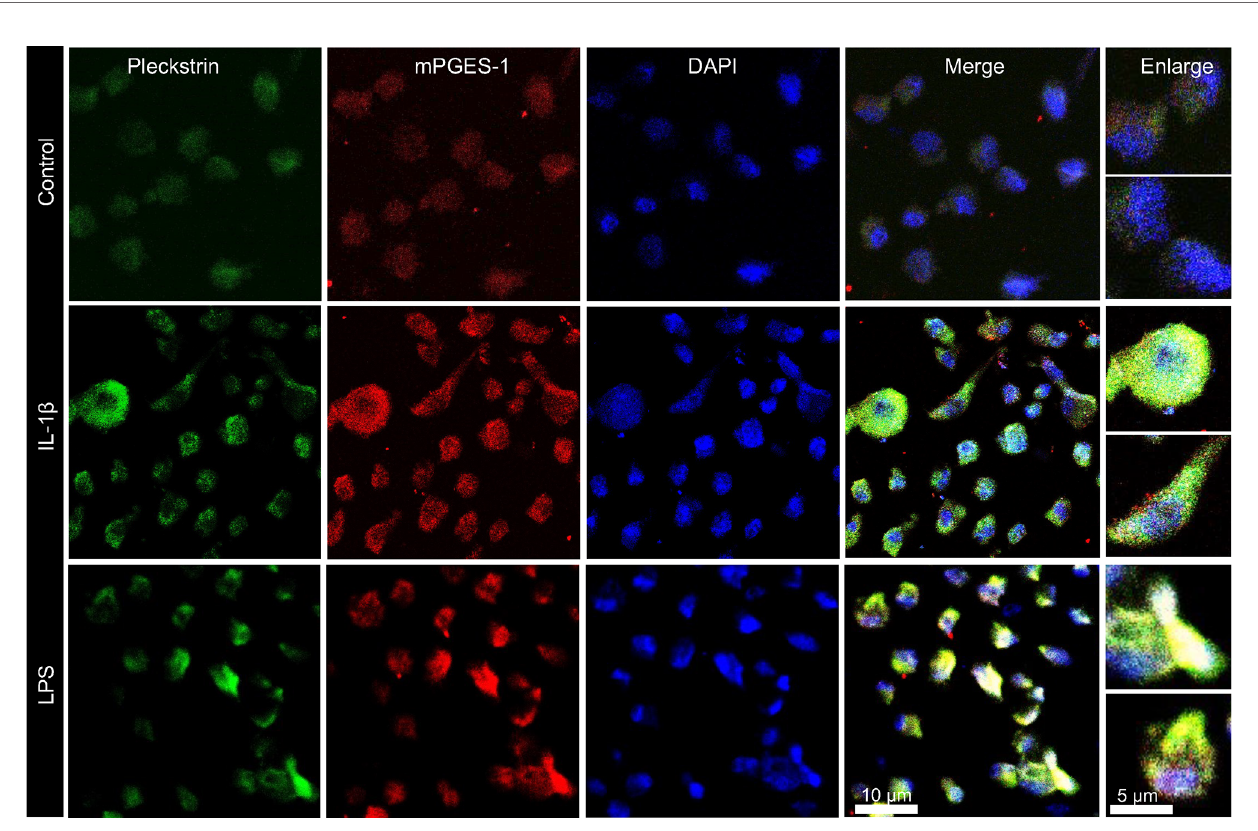
FIGURE 6 | Visualization and co-localization of pleckstrin protein with mPGES-1 in unstimulated control and IL-1 b or LPS stimulated HGFs using confocal microscopy. Immuno fl uorescence staining of fi broblast cells showing co-localization of pleckstrin (green) with mPGES-1 (red), an in fl ammatory marker, and DAPI (blue), a nuclear marker. Scale bars: 10 m m and 5 m